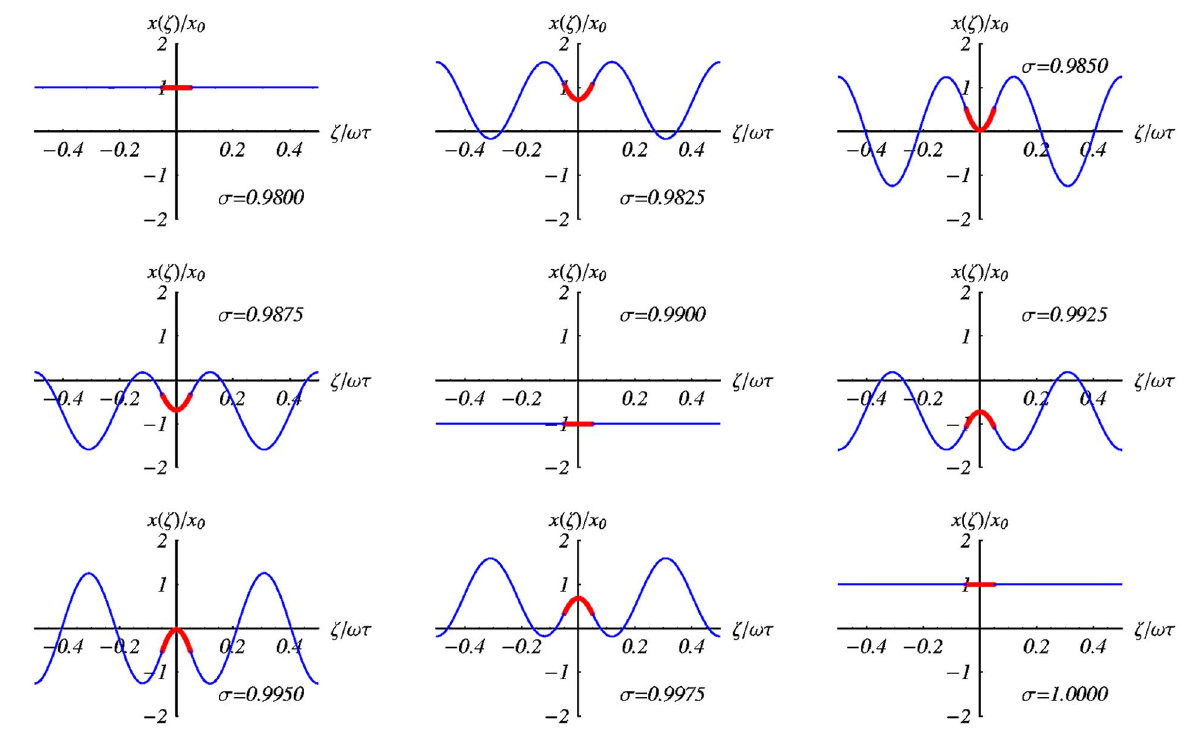
FIG. 3. (Color) Steady-state evolution of an infinite bunch train with / (cid:7) 0 : 1 , Q (cid:7) 10 3 , (cid:8) (cid:7) 100 ’ , " (cid:7) 100 , and !. (cid:7) 5 : 25 ’ during the last betatron period of the